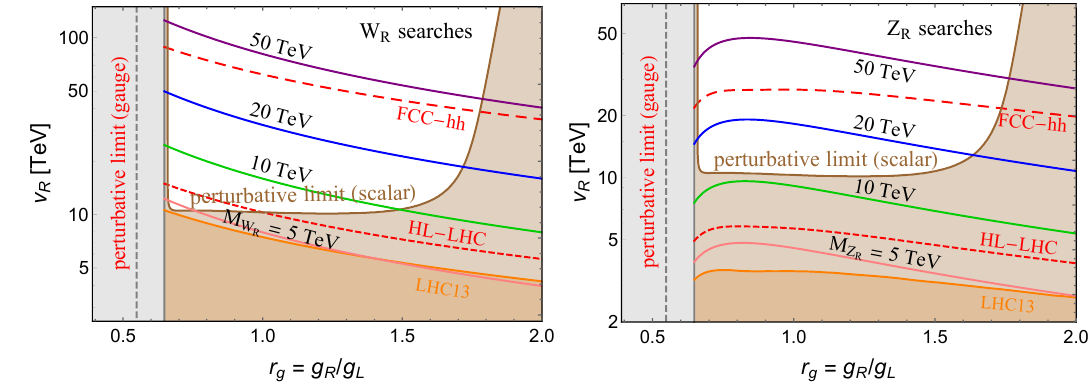
Figure 8 . Lower bounds on the v R scale in the minimal LRSM, as functions of r g , from the direct searches of W R and Z R bosons at LHC 13 TeV (shaded orange), and future prospects at the HL- LHC 14 TeV with an integrated luminosity of 3000 fb (cid:0) 1 (short-dashed red) and the 100 TeV collider FCC-hh with a luminosity of 30 ab (cid:0) 1 (long-dashed red). The shaded gray regions are excluded by the perturbativity constraints up to the GUT scale, with the vertical dashed line corresponding to the absolute theoretical bound in eq. (2.6). The shaded brown regions are excluded by the perturbativity limits from the scalar sector, discussed in section